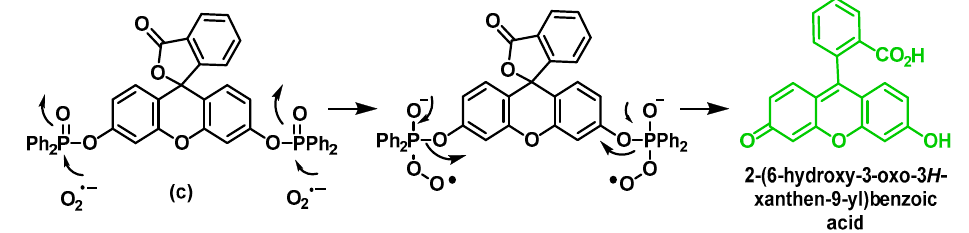
Figure 67. Mechanism of fluorescent response of probe (c) to O 2•– .